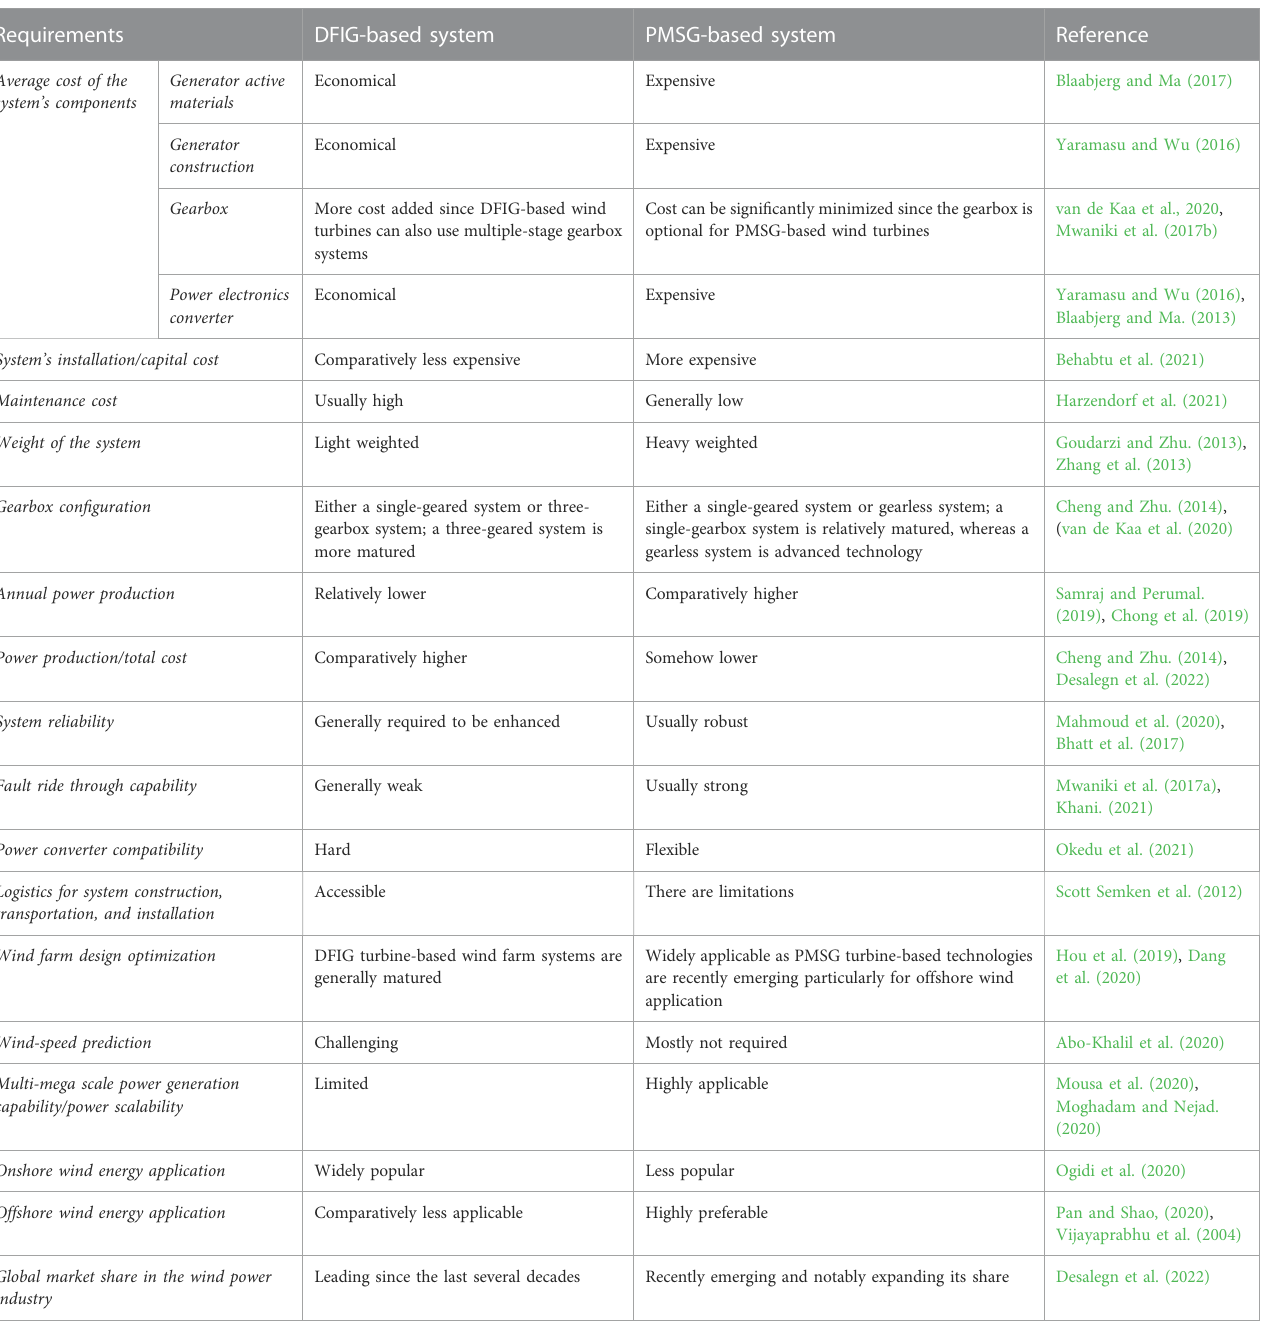
TABLE 1 Comparison of DFIG- and PMSG-based wind energy harvesting